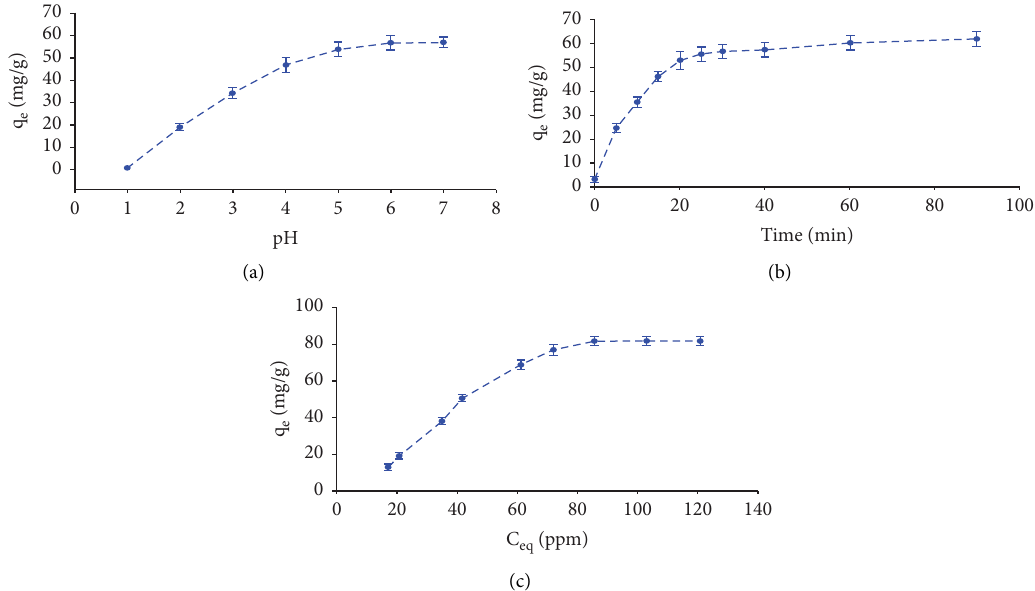
Figure 3: Optimization of Zn(II) biosorption by D. tsuruhatensis SA-101: (a) efect of initial pH; (b) efect of contact time; (c) efect of metal ion